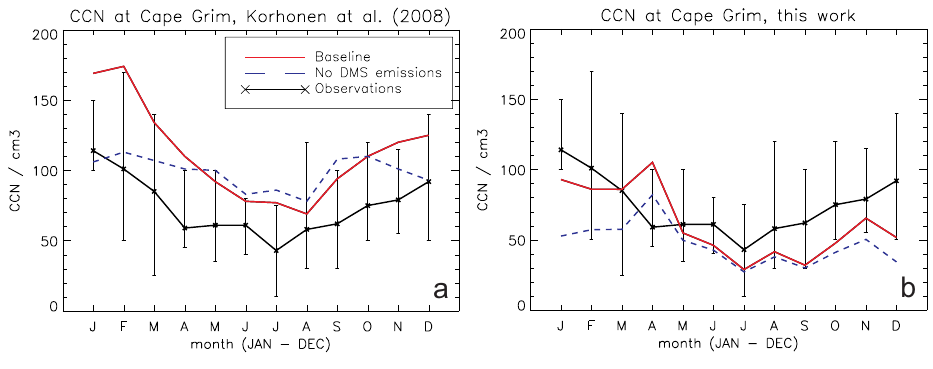
Fig. 7. Comparison of CCN from two GLOMAP model runs with and without DMS emissions, against observations from Cape Grim (Ayers and Gras, 1991), (a) from Korhonen et al. (2008), with sub-micron sea spray emissions, (b) from this study, without sub-micron sea spray emissions. Error bars show the range of monthly median values for the years 1981 to 1989 from the CCN observations.